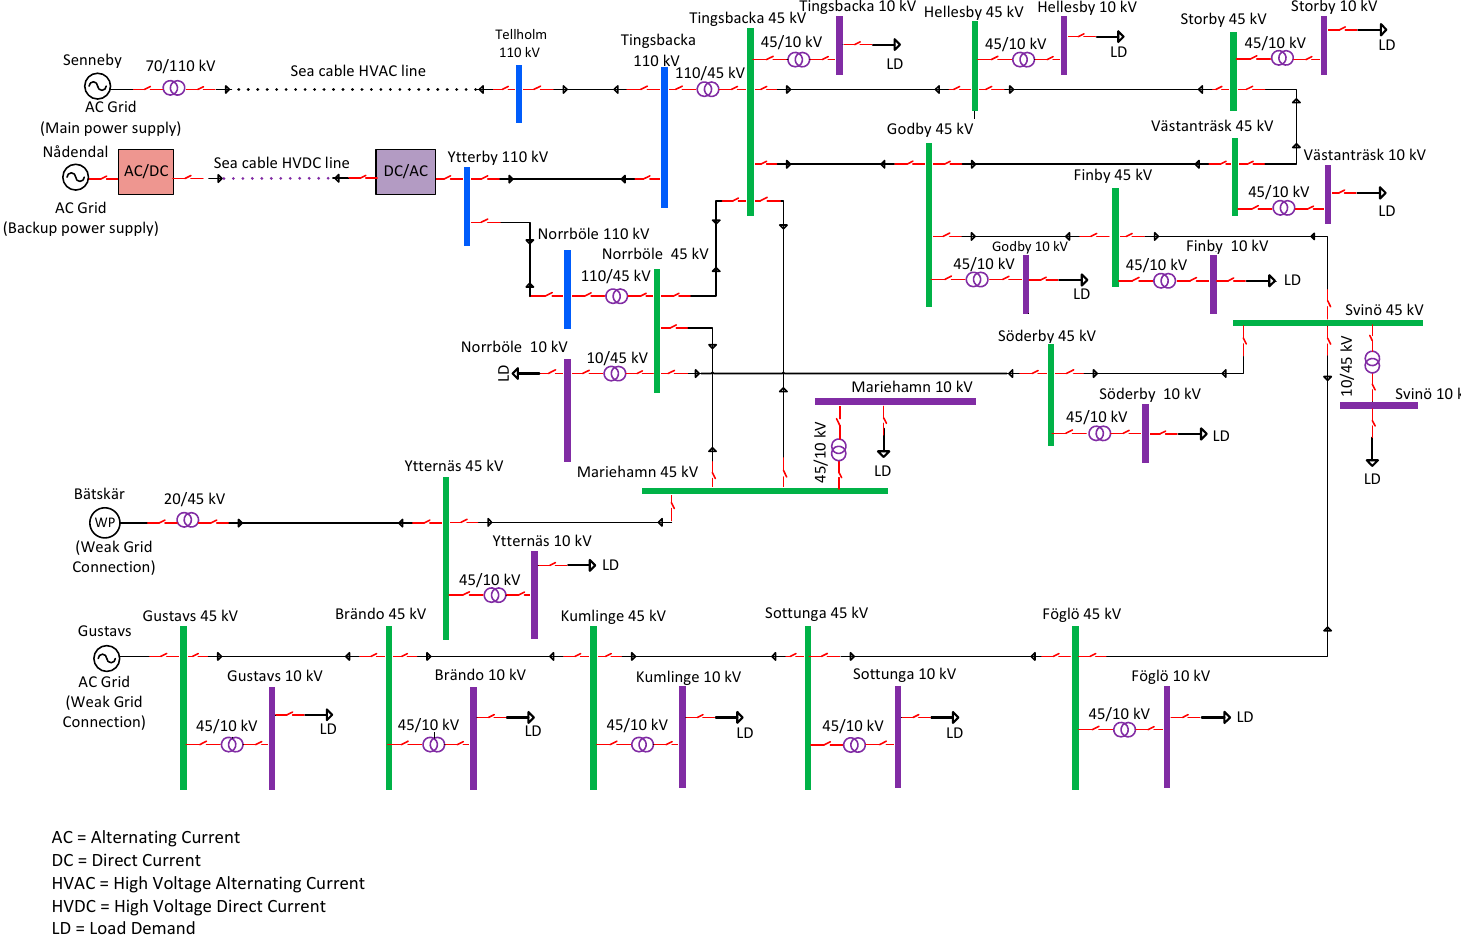
Figure 7. Single line diagram of the Åland Islands’ power system.